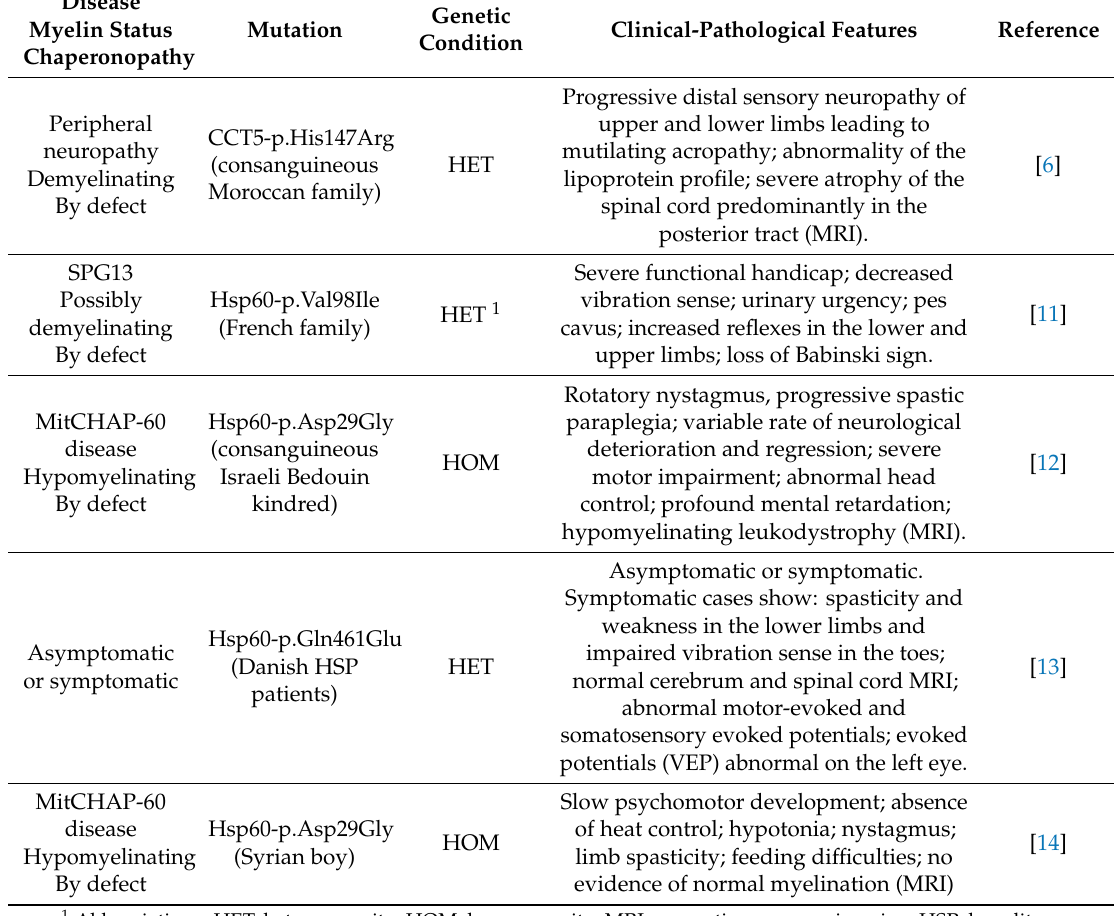
Table 1. Diseases with myelin abnormality associated with chaperone gene